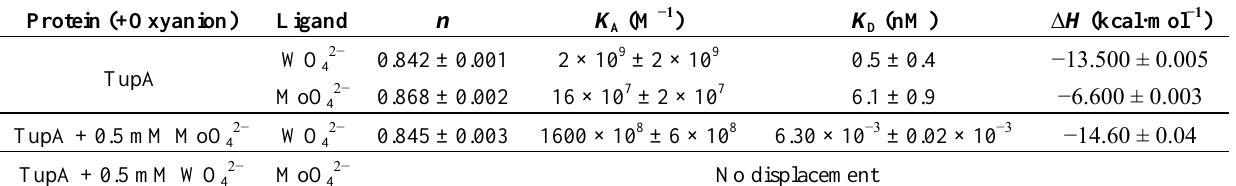
Table 1. Data for the ITC analysis of oxoanion binding to TupA and ModA proteins at 30 °C. Protein